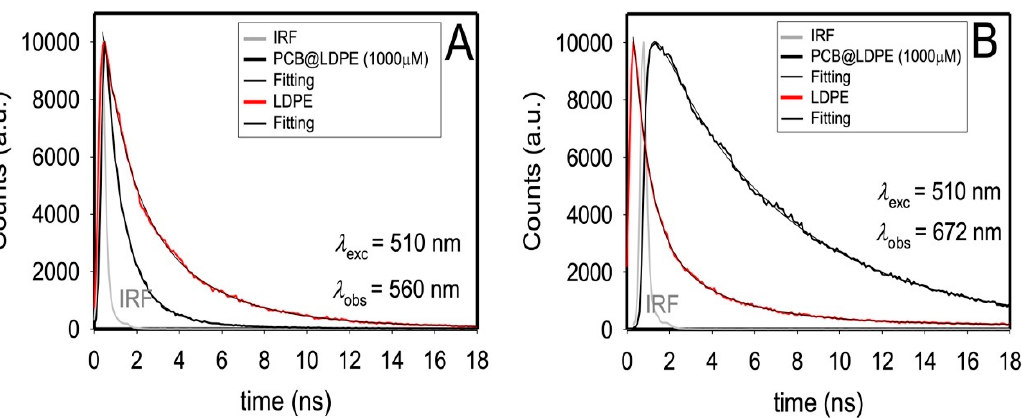
Figure 3. PL decays of solid 1000 µ M-PCB@LDPE films at 298 K (black lines). The excitation and monitoring wavelengths are indicated directly in the graph ( A and B ). The data for LDPE (red lines) are added for comparison